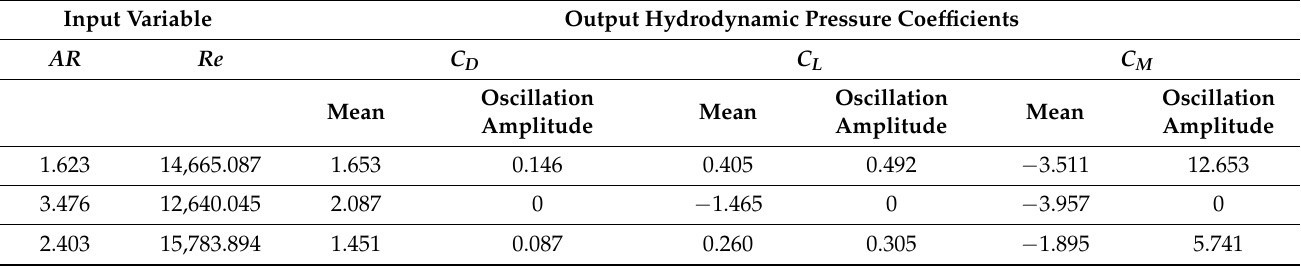
Table A1. Observed response from CFD simulations for the initial training